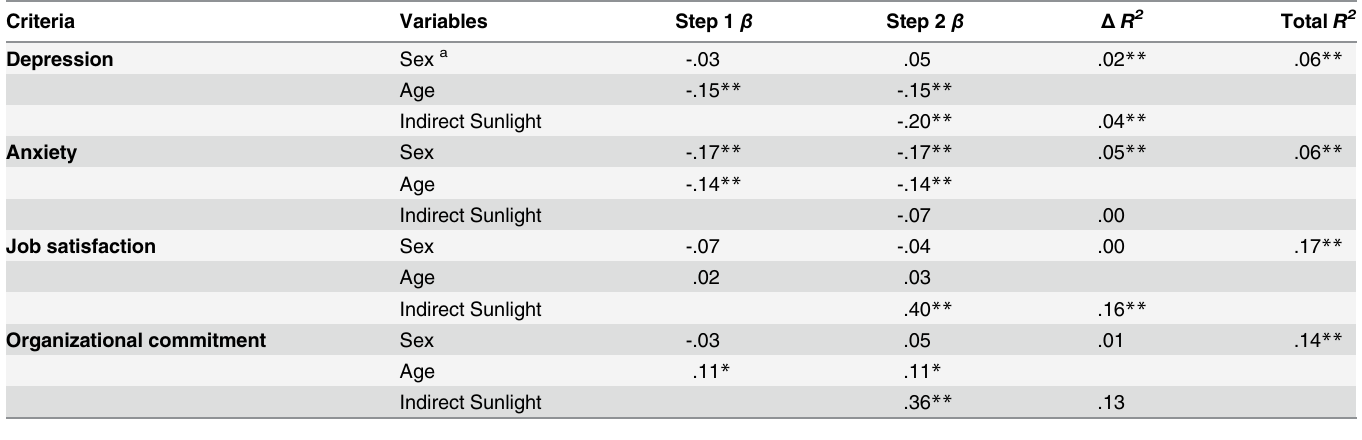
Table 6. Effects of indirect sunlight exposure on outcome variables.